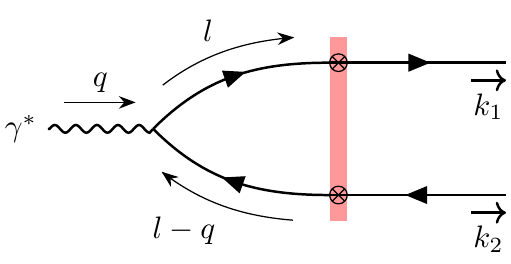
Figure 1 . CGC EFT diagram for the production of a quark anti-quark pair in DIS. The red rectangle and crosses represent the effective interaction of the quark and the anti-quark with the background field representing the small- x content of the